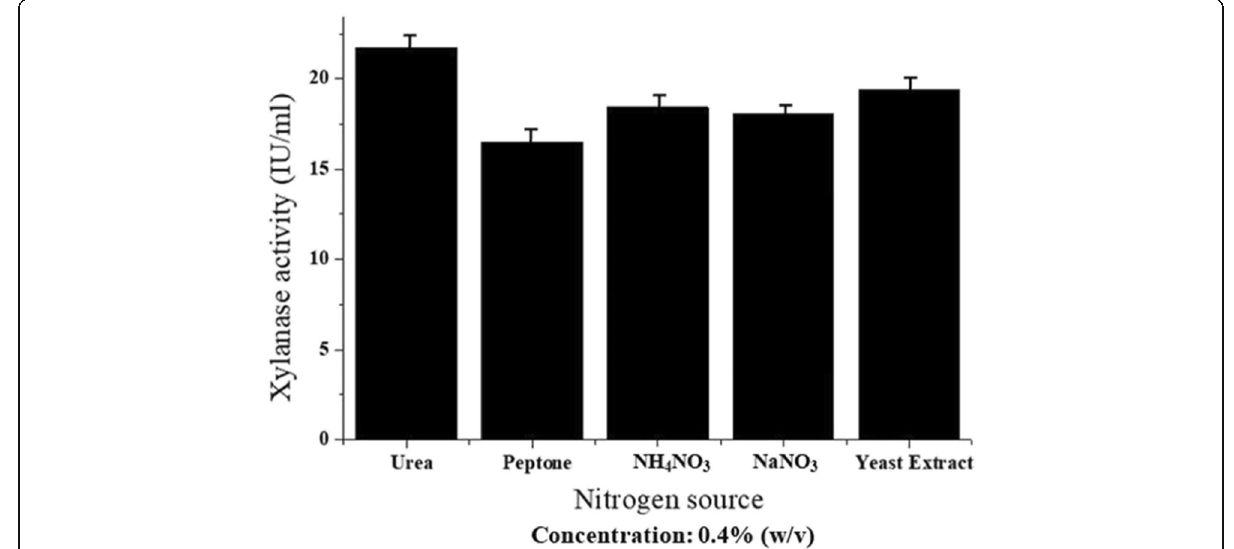
Fig. 6 Effect of different nitrogen sources on xylanase activity of the bacterium Pseudomonas